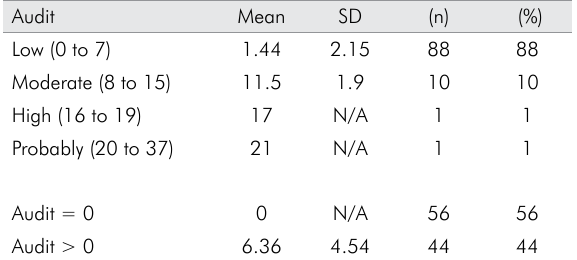
Table 5. Mean scores (SD) of alcohol dependence according to AUDIT